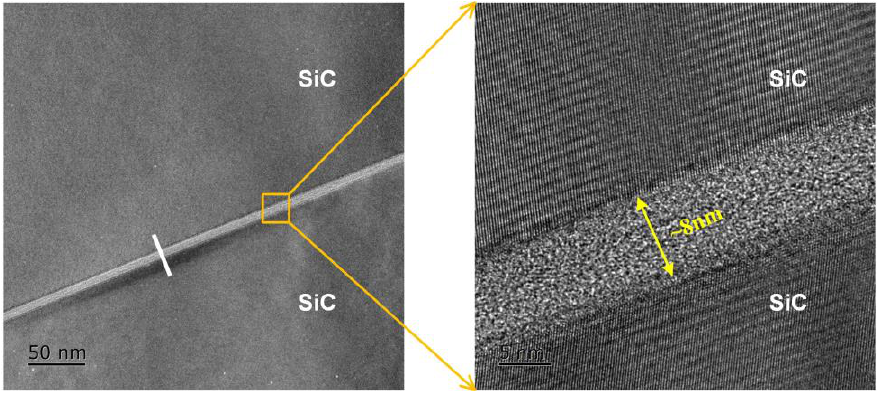
Figure 6. TEM image of the SiC–SiC bonding interface. Sensors 2020 , 20 , x FOR PEER REVIEW